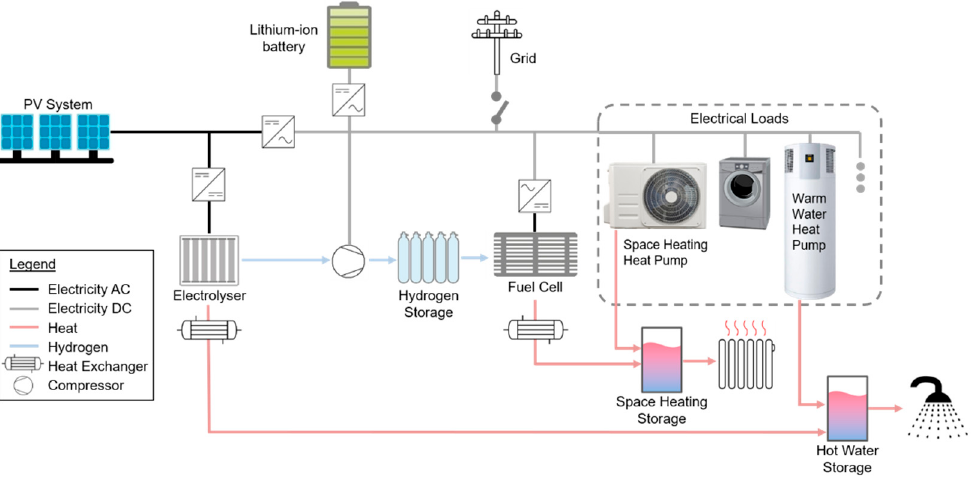
Figure 3. System layout of the single household energy system (image sources: [21,22]).